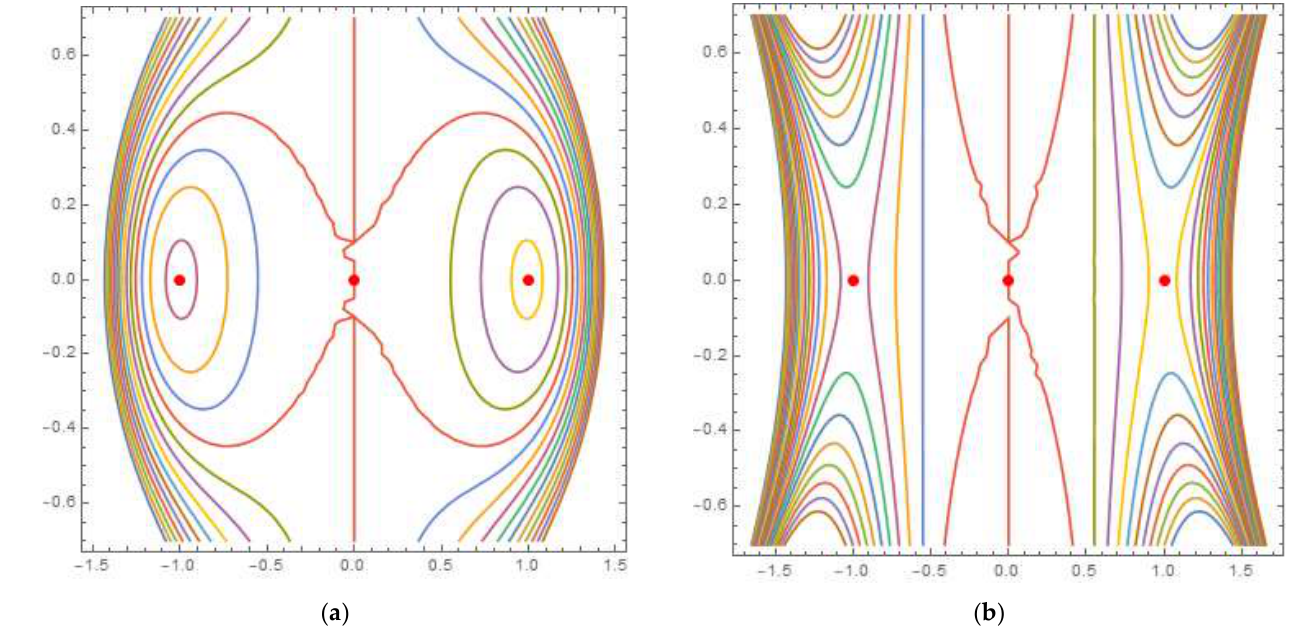
Figure 2. Trajectories of the dynamical system (17), where ( a ) a 1 = 1, a 2 = 0, a 4 = 0, q 1 = 1, q 2 = 1, q 3 = 1, γ = 1, δ = 1, β = 1; ( b ) a 1 = 1, a 2 = 0, a 4 = 0, q 1 = 1, q 2 = 1, q 3 = − 1, γ = 1, δ = 1, β = 1.